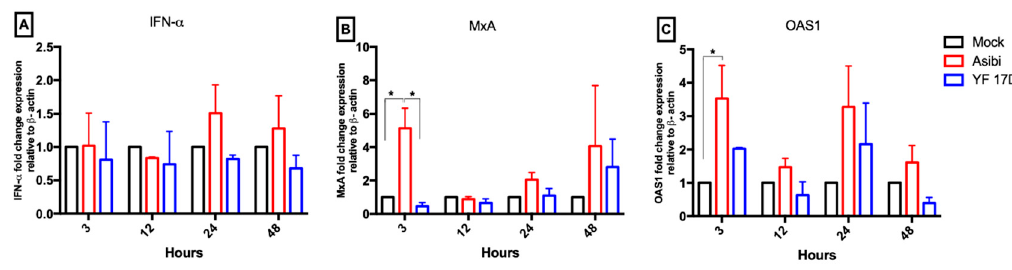
Figure 5. Asibi elicits higher innate antiviral response than YF-17D. Hela cells were infected with Asibi or YF-17D at MOI = 1. At the indicated time points, cells were processed, and RNA extracted. Expression levels of antiviral molecules IFN- α ( A ), MxA ( B ) and OAS1 ( C ) were determined by RT-qPCR and expression levels expressed as fold change compared to the expression levels in mock uninfected HeLa cells with β -actin as endogenous control. Data represent two independent experiments performed in triplicates and are presented as mean ± SEM. * = p ≤ 0.05.